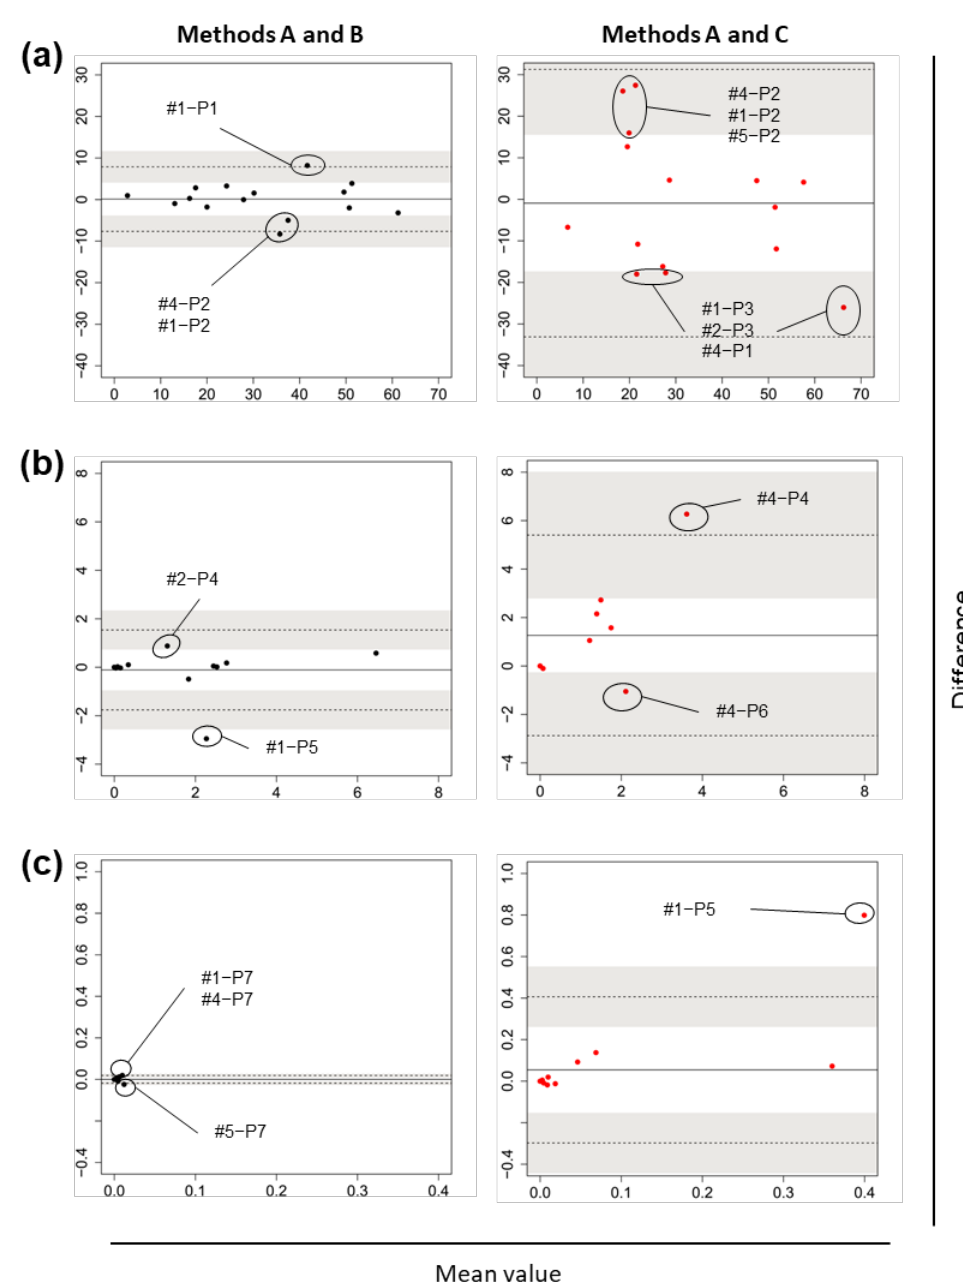
Figure 4. Research I: Bland–Altman plots of the relative abundance of fecal bacteria at the phylum level obtained by each method from five adult volunteers. Comparisons between Methods A – B (left) and Methods A – C (right). The relative abundance of bacteria in each specimen was plotted. ( a ) Their maximum abundance in any of the specimens was ≥10%; ( b ) ≥1% and <10%; ( c ) <1%. Solid lines indicate the means of the differences between the two test values, dotted lines indicate the limits of agreement (the mean of the difference ± 1.96 × standard deviation), and the gray shaded area indi- cates the 95% confidence interval of the limits of agreement. For Methods A and B, stool samples were collected using commercial collection tubes. For Method C, urine and stool samples were ap- plied to disposable diapers. For Methods B and C, the samples were stored at −80 °C for 2 months.